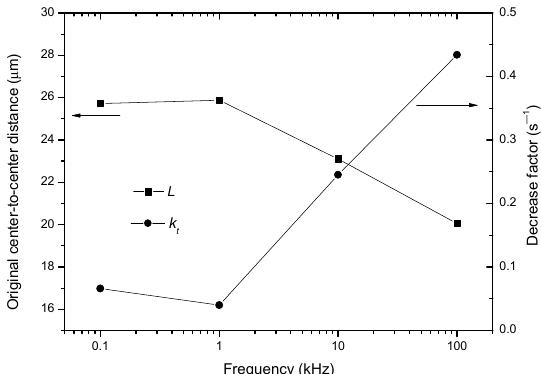
Figure 7. Dependencies of L and k t under different frequencies.